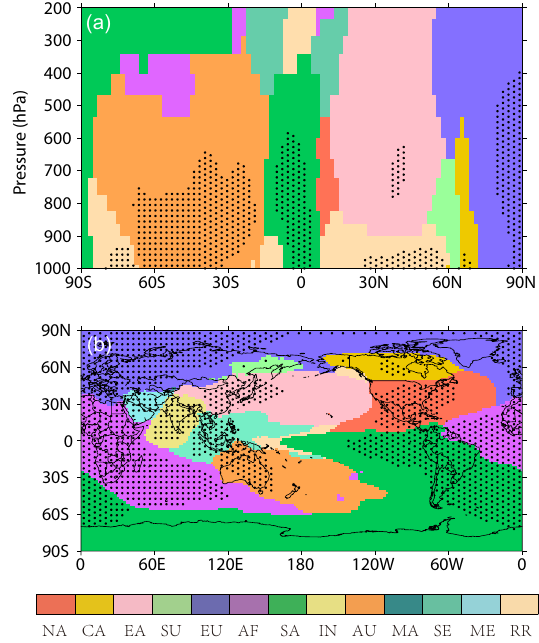
Figure 5. The most significant regional contributors to (a) zonal mean BC concentration over the Pacific (130 ◦ W–160 ◦ E), and (b) the column burden of BC in the troposphere (200–1000hPa, 2009–2011 average). Dotted area represents where the most signif- icant contributor accounts for more than 50% of the total